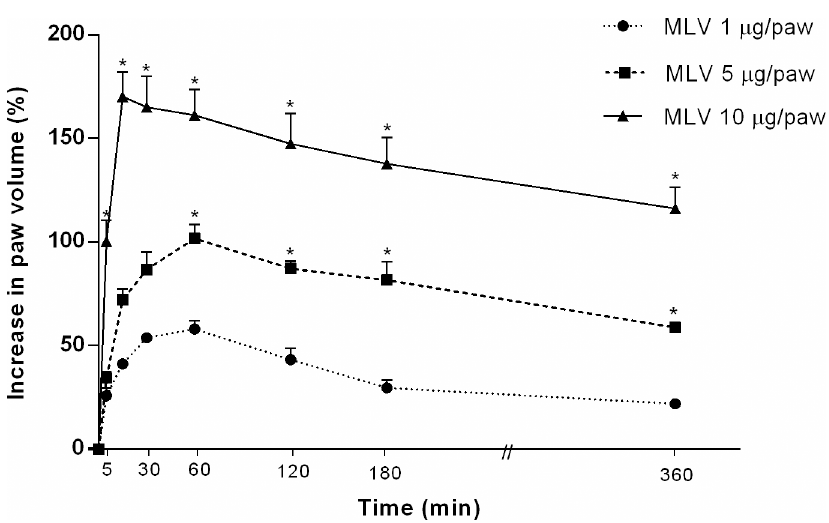
Fig 1. Time course of rat paw edema induced by selecteddoses of Micrurus lemniscatus venom. Increasedpaw volume was determinedat varioustime points after intraplantarinjectionof MLV (1–10 μ g/ paw) into one paw and apyrogenicsalineinto the contralateral paw (control paw). The increasein volume of each paw (edema) was measured using a plethysmometer. Differences betweenpaws were expressedas a % increasein paw volume. Values are the mean ± SEM of five animals. * p < 0.05 comparedwith MLV (1 μ g/ paw). https://doi.org/10.1371/journal.pntd.0005874.g001 post-injection. Injection of MLV into the peritoneal cavity induced significant degranulation of mesentery mast cells at doses of 250 and 500 μg/animal (30% and 70%, respectively) (Fig 2B–2D). Degranulation in negative controls was less than 10%.